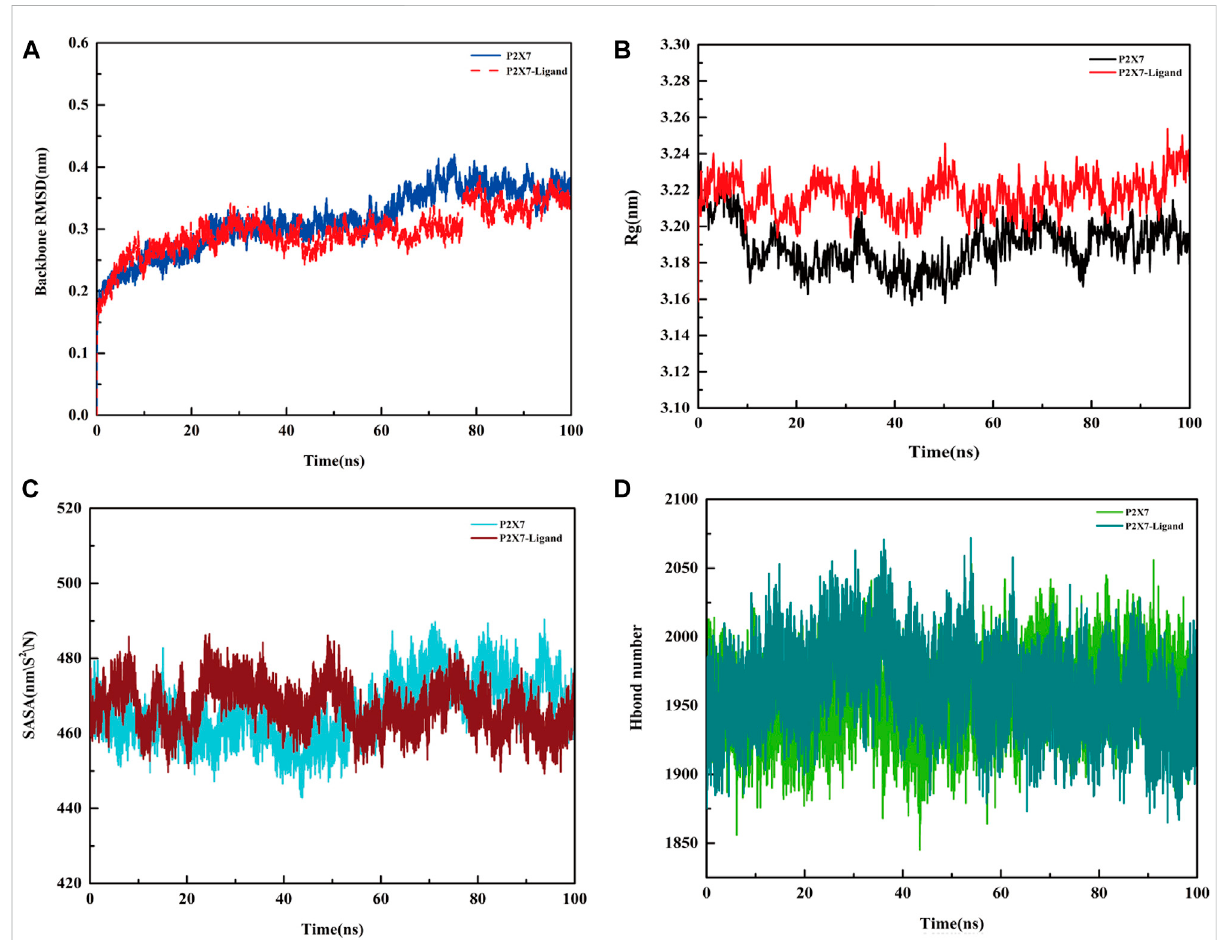
FIGURE. 8 Molecular dynamics simulation of the P2X7R protein and protein ‒ ligand. (A) Variation in RMSD values of the protein (P2X7R, blue line) and protein ‒ ligand (Z1456467176, red line) systems with time. (B) Rg values of the protein (black line) and protein ‒ ligand (red line) systems with time. (C) SASA area of the protein (blue line) and protein ‒ ligand (red line) systems over time. (D) The hydrogen bond formed between the protein (light green line), protein ‒ ligand (dark green line) system and